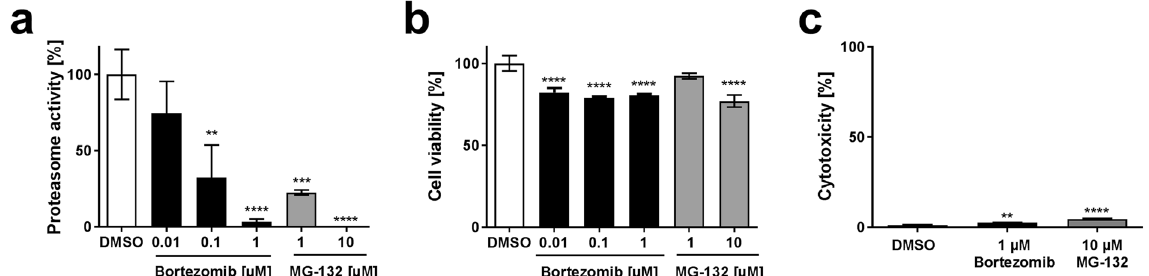
Figure 1. Effect of proteasome inhibitors on HeLa cells. HeLa cells were incubated for 24 h in the presence of MG-132, Bortezomib or DMSO and assayed for ( a ) chymotrypsin-like proteasome activity, ( b ) ATP amount and ( c ) release of lactate dehydrogenase. Error bars indicate means ± standard deviation of one experiment performed at least in triplicate. Statistics: One-way ANOVA and Bonferroni’s multiple comparisons test ( * p ≤ 0.05, ** p ≤ 0.01, *** p ≤ 0.001, **** p ≤